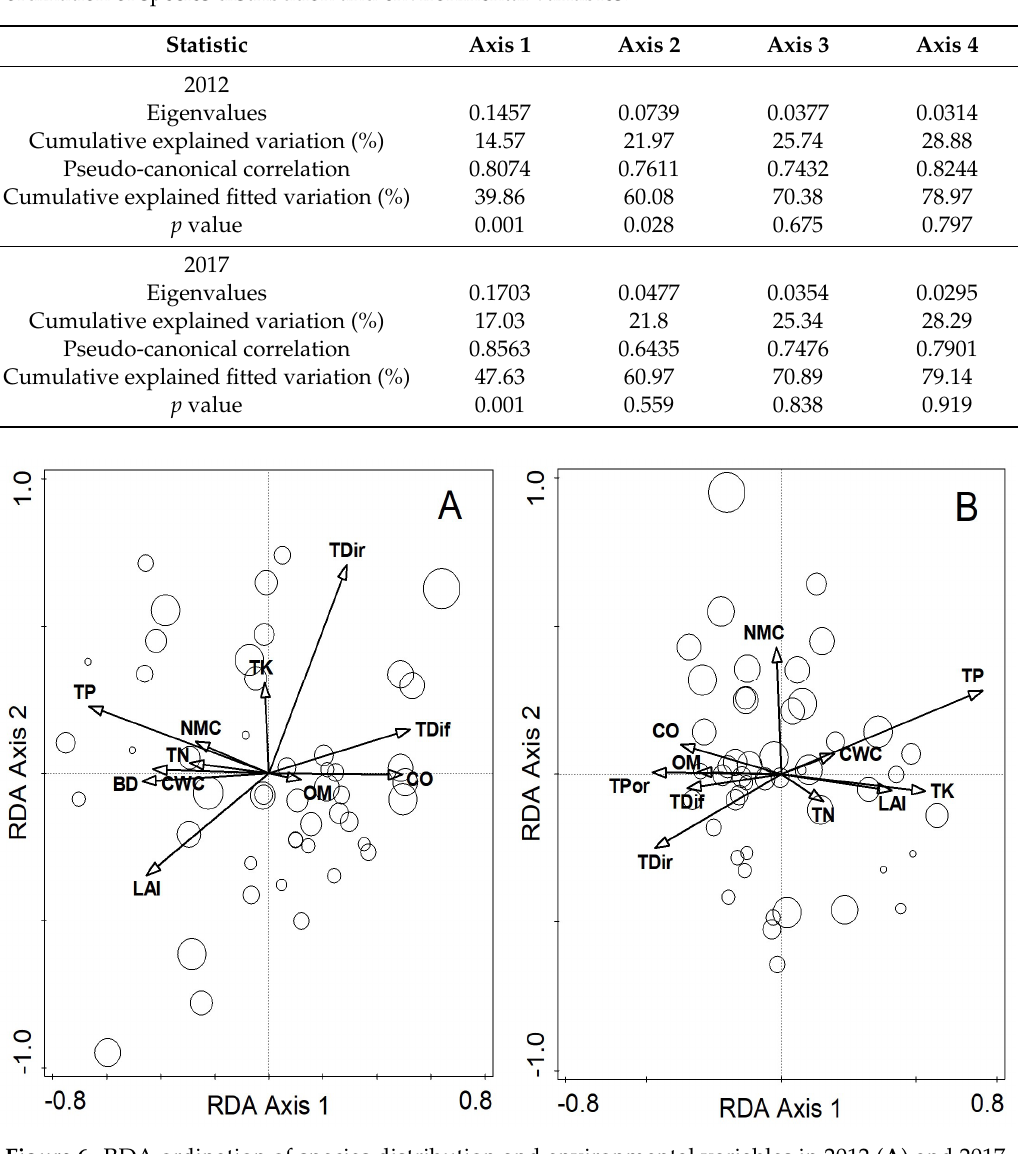
Figure 6. RDA ordination of species distribution and environmental variables in 2012 ( A ) and 2017 ( B ). Environmental variables: OM = organic matter; TN = total nitrogen; TP = total phosphorus; TK = total potassium; NMC = natural moisture content; BD = bulk density; CWC = capillary water capacity; TPor = total porosity; CO = canopy openness; LAI = leaf area index; TDir = transmitted diffuse solar radiation; TDif = transmitted diffuse solar radiation (mols · m −2 · d −1 ).